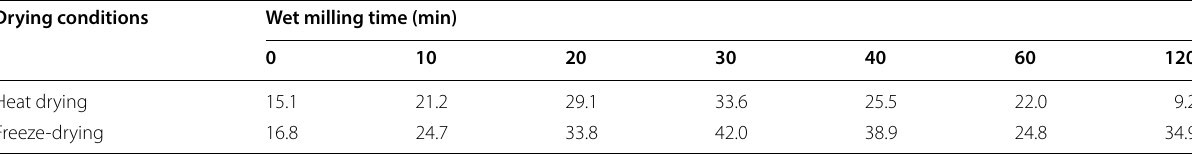
Table 2 The percentage of produced WF for mesh pass 90–180 μm Drying